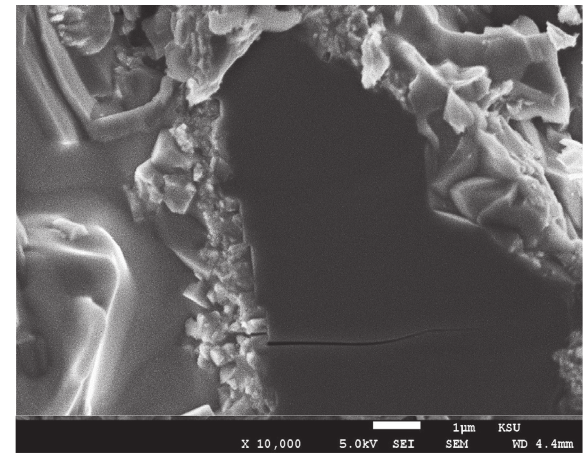
Figure 3: Secondary electron image of fracture surface of as-cast composite